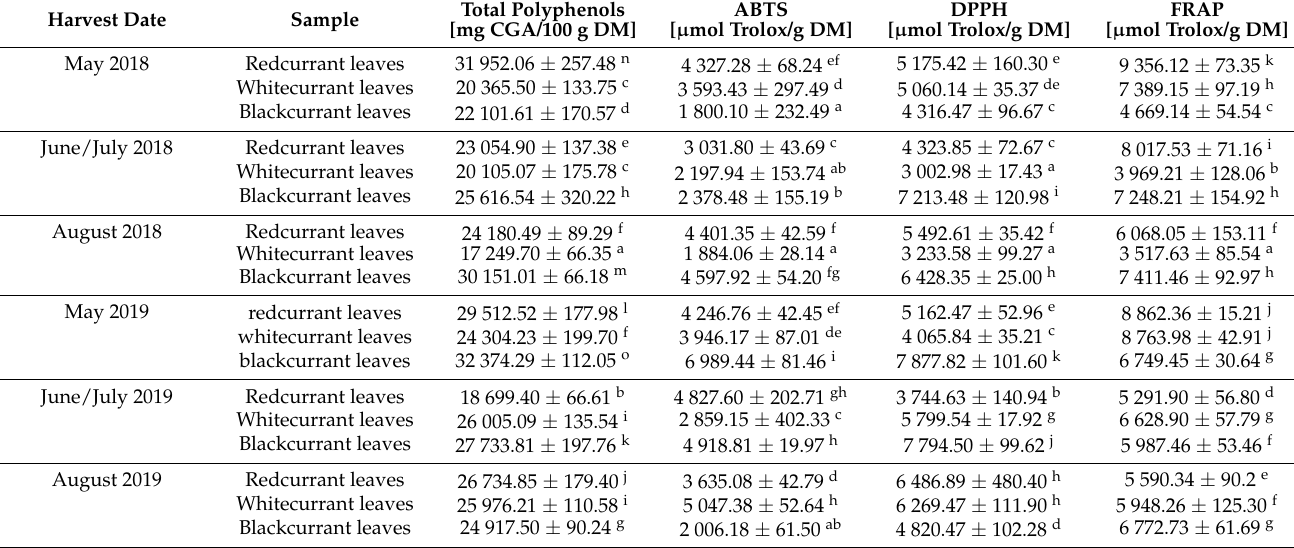
Table 2. Polyphenol content and antioxidant activity of the leaves of three currant species harvested at different dates in 2018 and